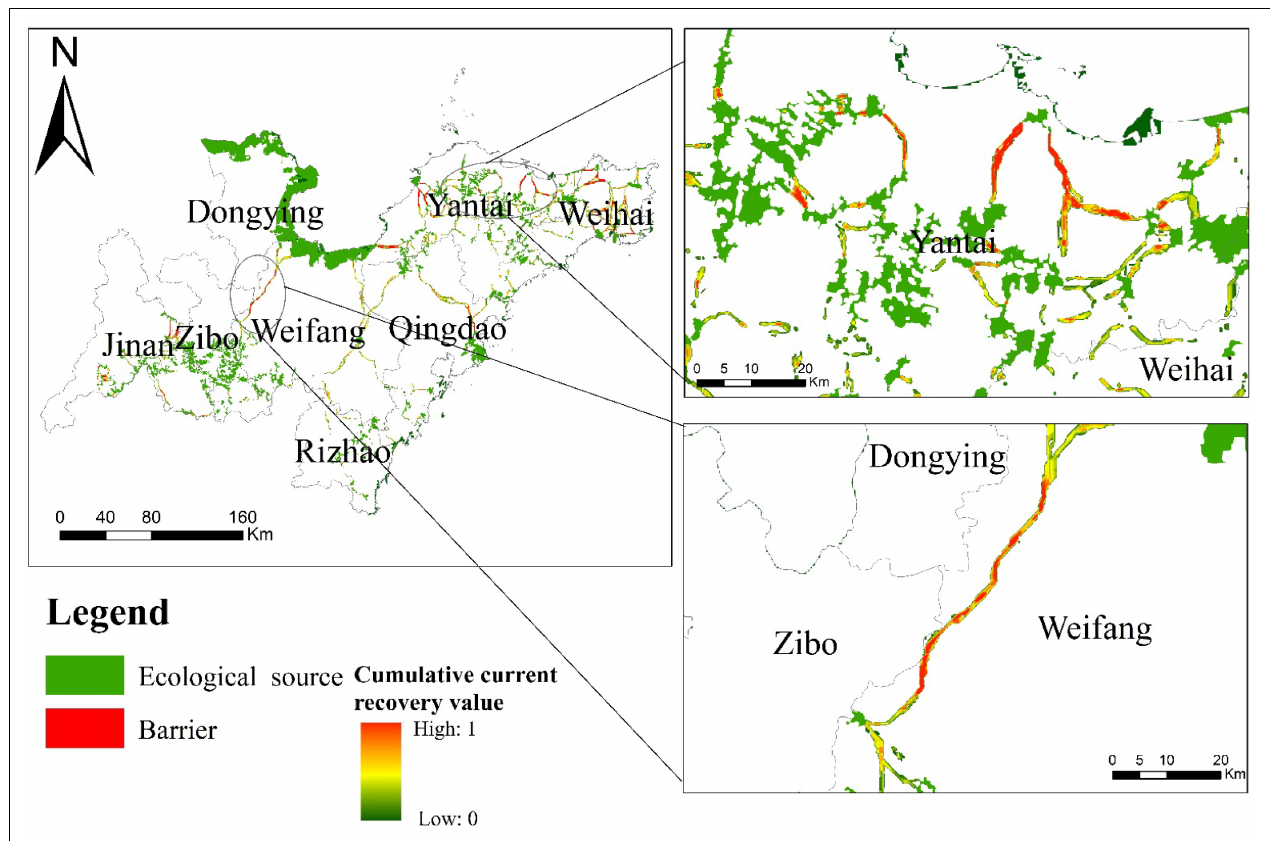
FIGURE 11 | Spatial distribution of restoration priority areas in the ENs of Shandong Peninsula urban